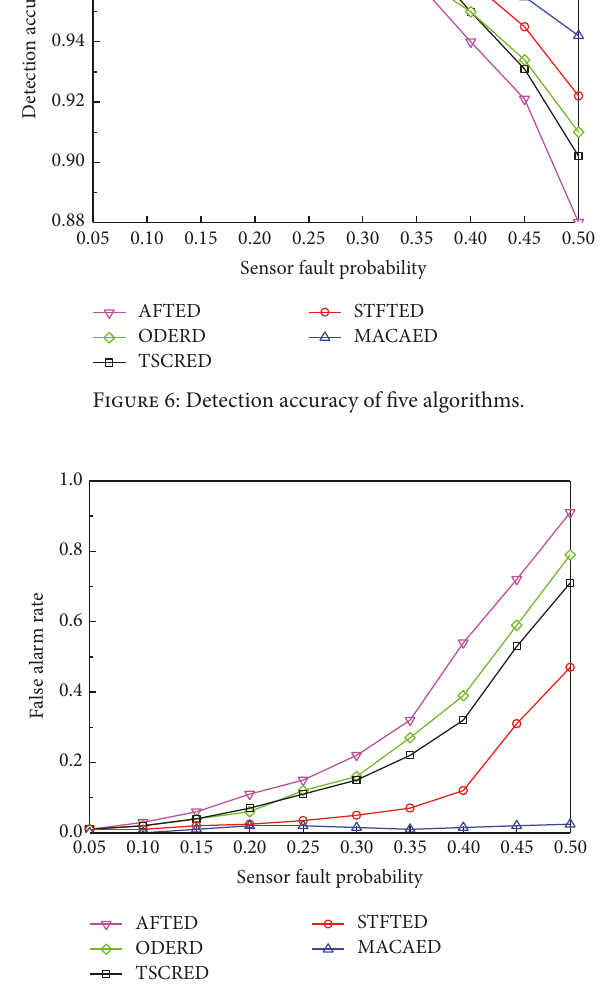
Figure 7: False alarm rate of five